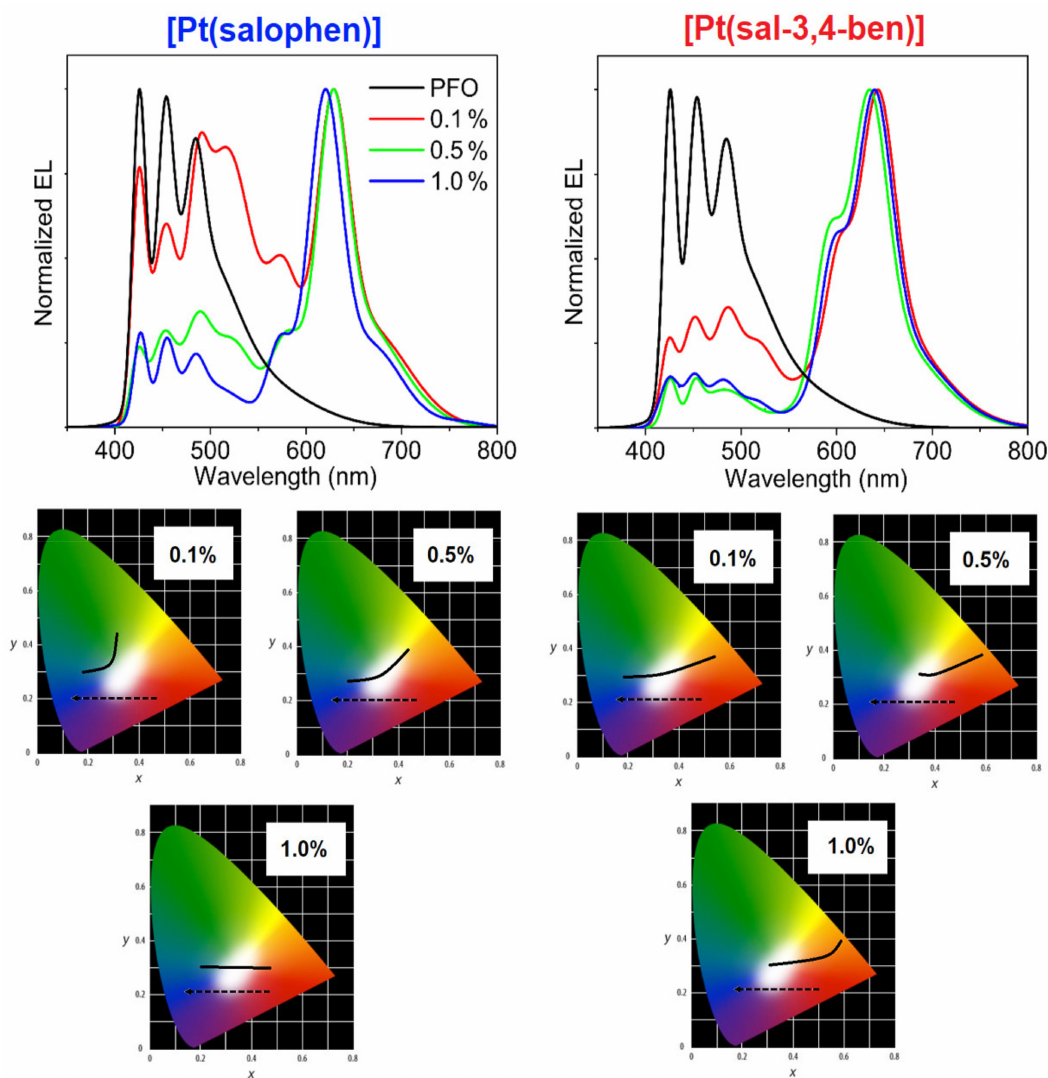
Figure 5. Electroluminescence spectra for [Pt(salophen)] and [Pt(sal-3,4-ben)] OLEDs with different concentrations, at maximum EQE. At the bottom, CIE1931 chromaticity coordinates the dependence on the bias of PFO:[Pt(II)]-based OLEDs for concentrations of 0.1, 0.5, and 1.0% of the Pt(II) complexes (arrows indicate the applied voltage increase and solid-lines represents the WOLEDs color